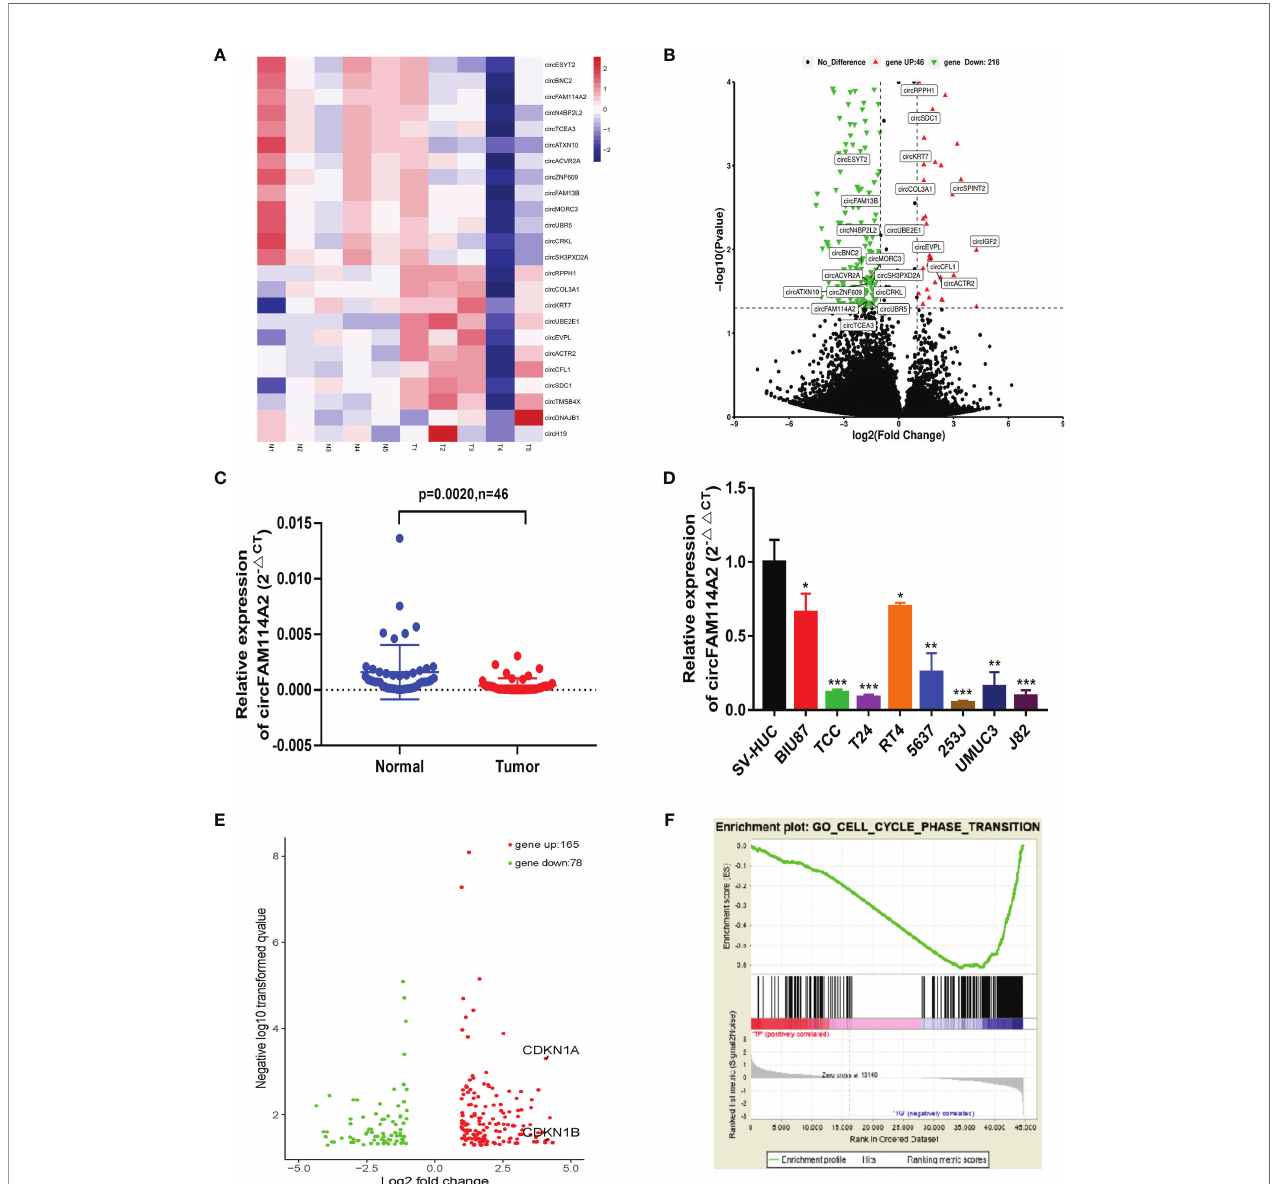
FIGURE 1 | CircFAM114A2 was downregulated in urothelial carcinoma and associated with cell cycle regulation pathways. (A) Heat map of RNA sequencing in fi ve pairs of urothelial carcinoma tissues. (B) CircRNAs with different expression levels were screened by fold change and p -value. (C) Quantitative real-time PCR (qRT- PCR) assay with divergent primers con fi rmed the low expression of circFAM114A2 in 46 pairs of human urothelial carcinoma tissues compared with their adjacent normal tissues. (D) The expressions of circFAM114A2 in SV-HUC and urothelial carcinoma cell lines were measured by qRT-PCR (Student ’ s t -test: * p < 0.05, ** p < 0.01, *** p < 0.001). (E) Genes with different expression levels screened by fold change and p -value in mRNA sequencing. (F) Gene set enrichment analysis (GSEA) showed that the enrichment occurred in the cell cycle transition-related genes, including P27 and P21